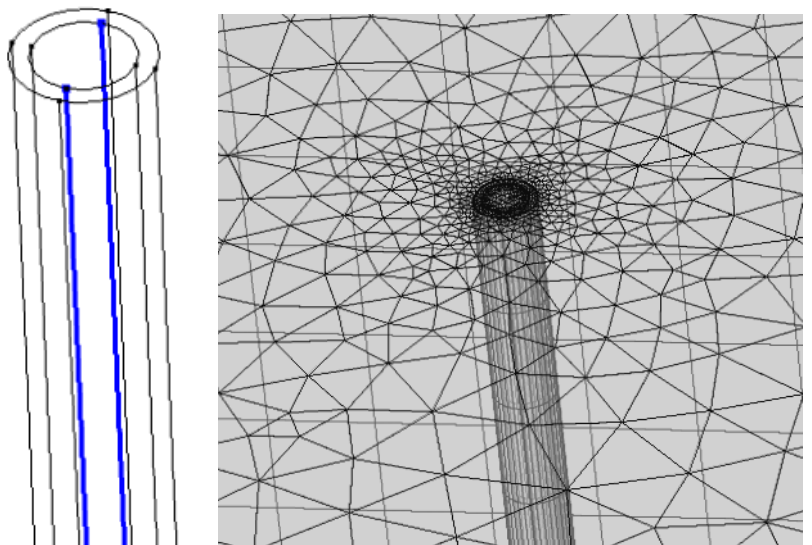
Figure 8. Model and mesh of the Shell Centre energy pile.